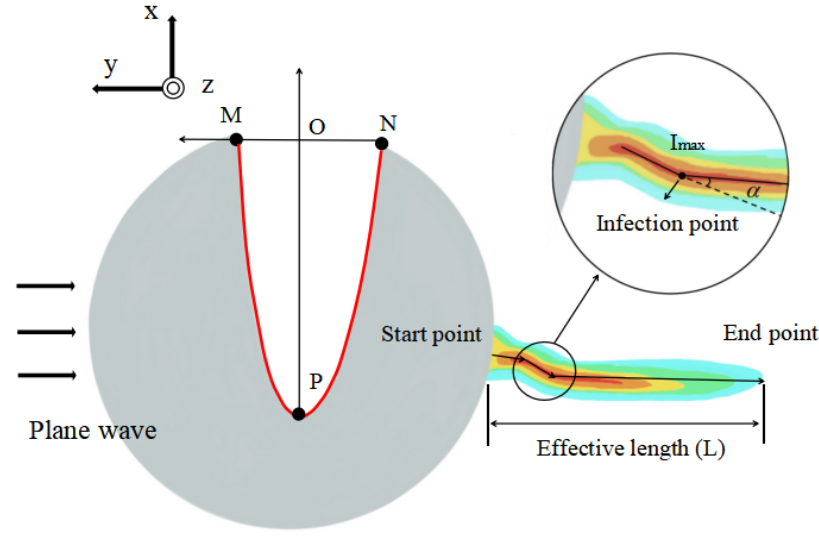
Figure 1. A 2D cross-section. The red curve represents the SCF. The coordinates of M , N , and P are (0, a ), (0, − b ), and ( − c , 0), respectively. The maximum electric field intensity of the optical hook is I max , and the boundary intensity of the optical hook is I max / √𝑒 . The effective length L is the distance from the start point to the end point, and the bending angle is α .